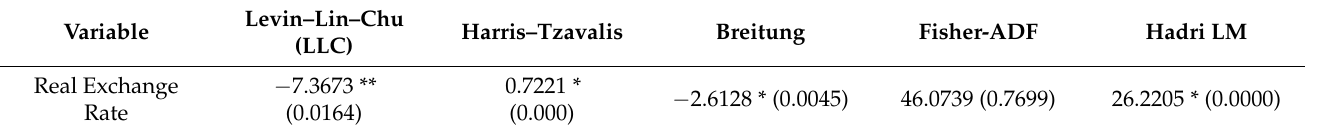
Table 1. Panel unit root tests.